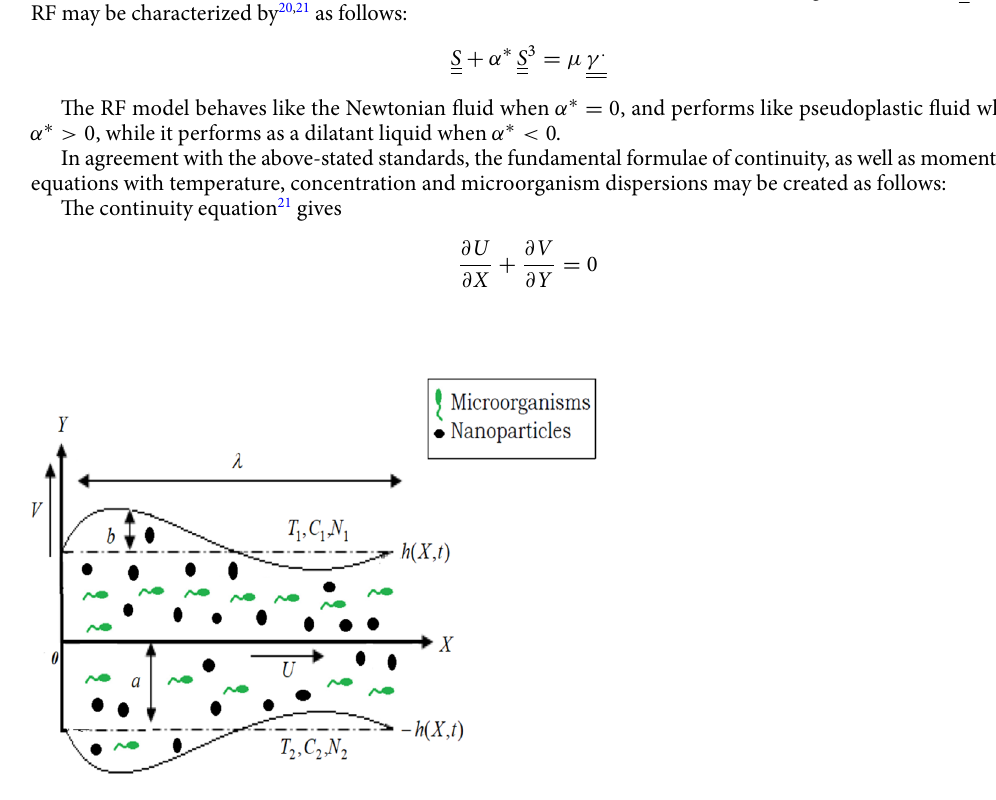
Figure 1. Depicts the theoretical